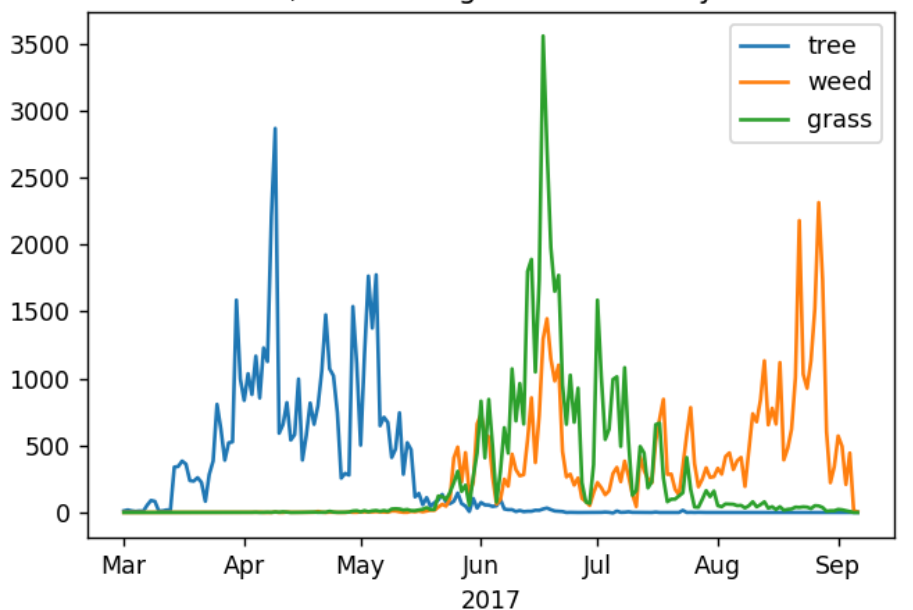
Figure 1. Time-series of total UK daily pollen counts ( y -axis), grouped by vegetation type. Plot shows: tree pollen (blue), weed pollen (orange), grass pollen